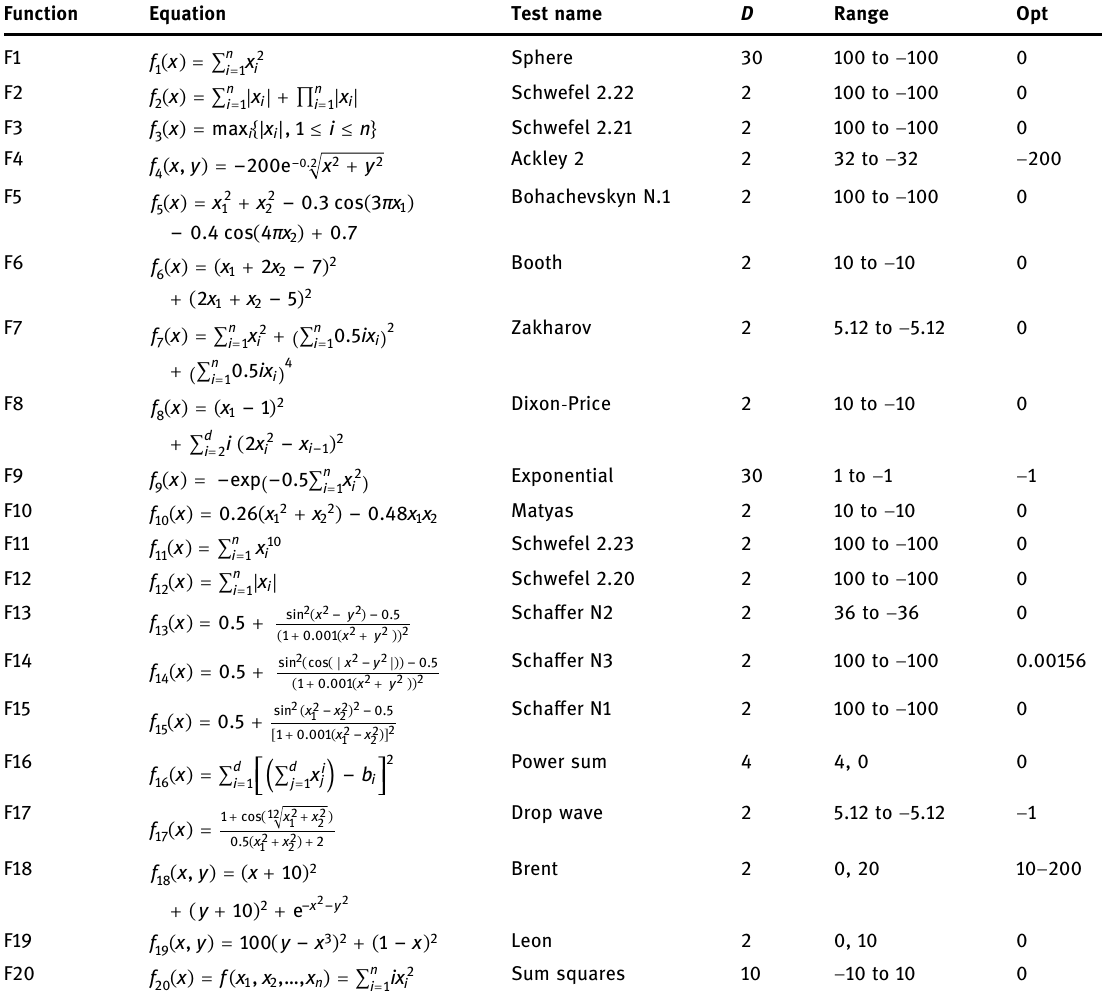
Table 1: Unimodal Benchmark functions Function